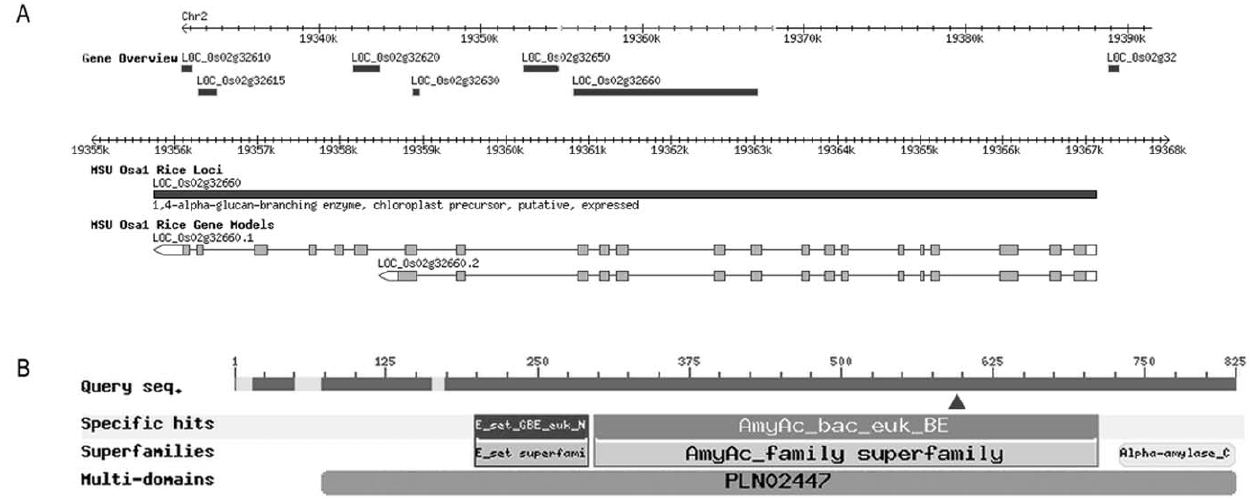
Figure 5. Physical location and domain structure of SBE3 gene. A: Diagram of genomic interval within the target region on chromosome 2 of Nipponbare. B: Conserved domain of predicted candidate gene SBE3 (LOC_Os02g32660). E_Set superfamily: early set domain associated with the catalytic domain of sugar utilizing enzymes; AmyAc_Family superfamily: alpha amylase catalytic domain; Alpha-amylase_C: alpha amylase, C-terminal all-beta domain; and m : Mutation